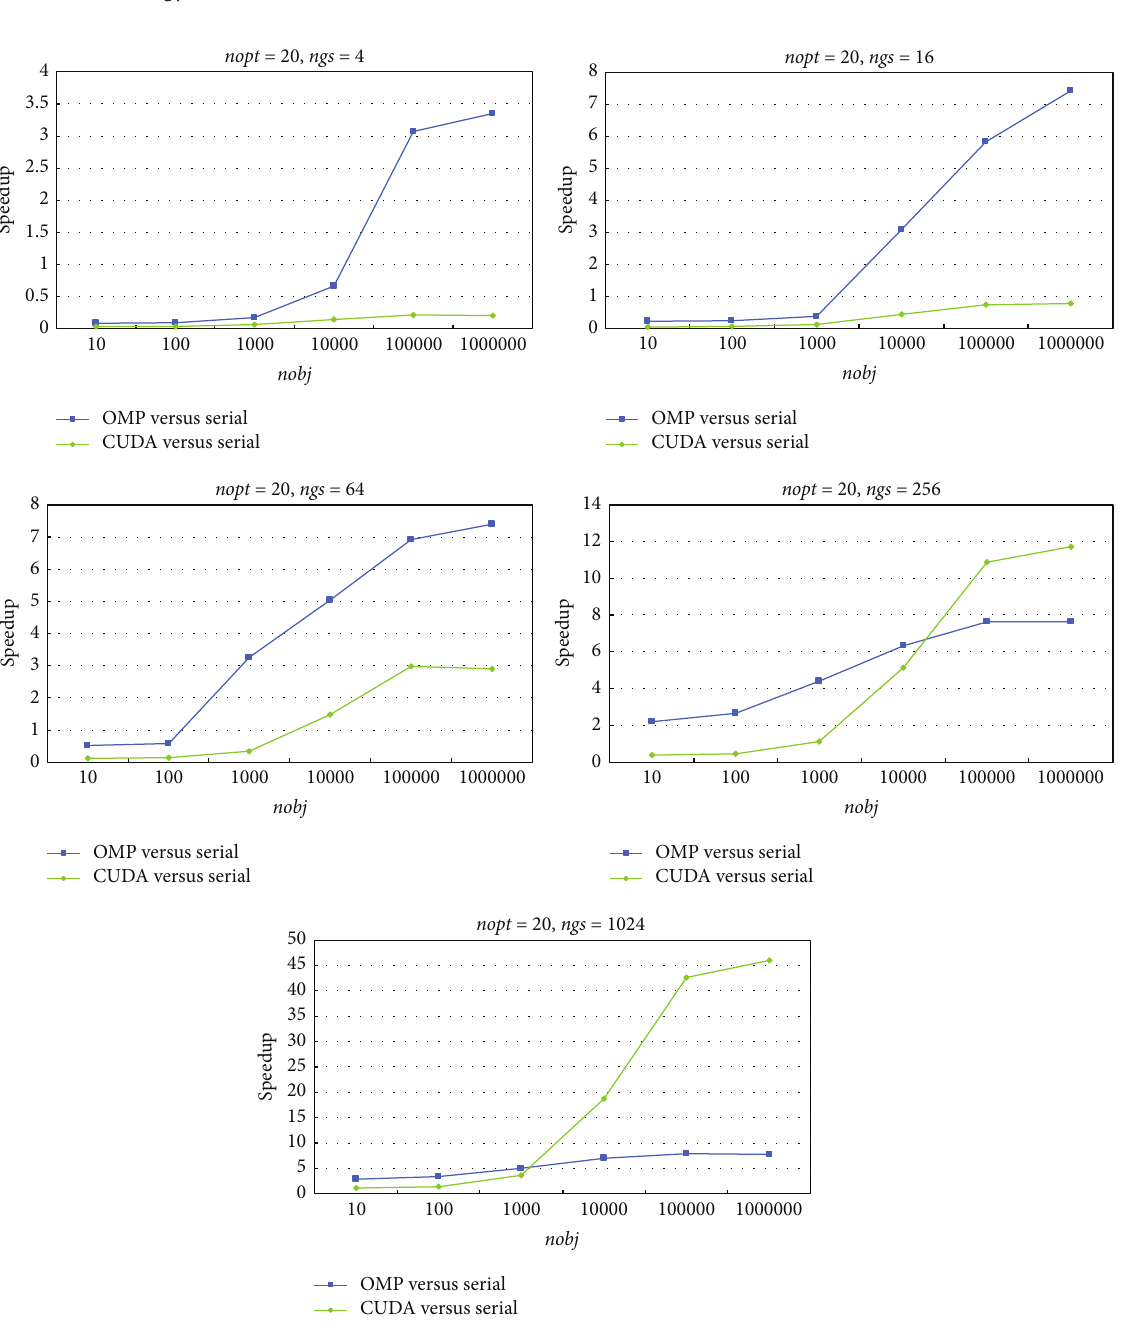
Figure 9: Relationship between the nobj and the speedup